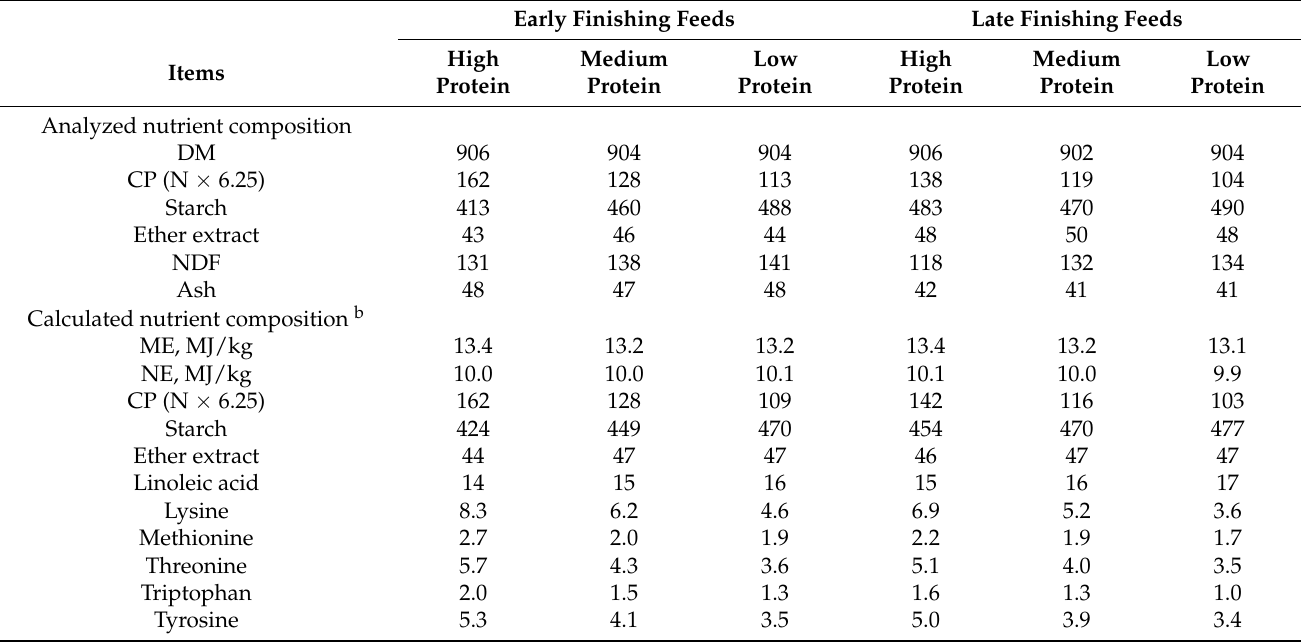
Table 3. Nutrient content (g/kg as-fed, unless otherwise indicated) of early (90 to 120 kg average body weight) and late finishing feeds (over 120 kg average body weight) a